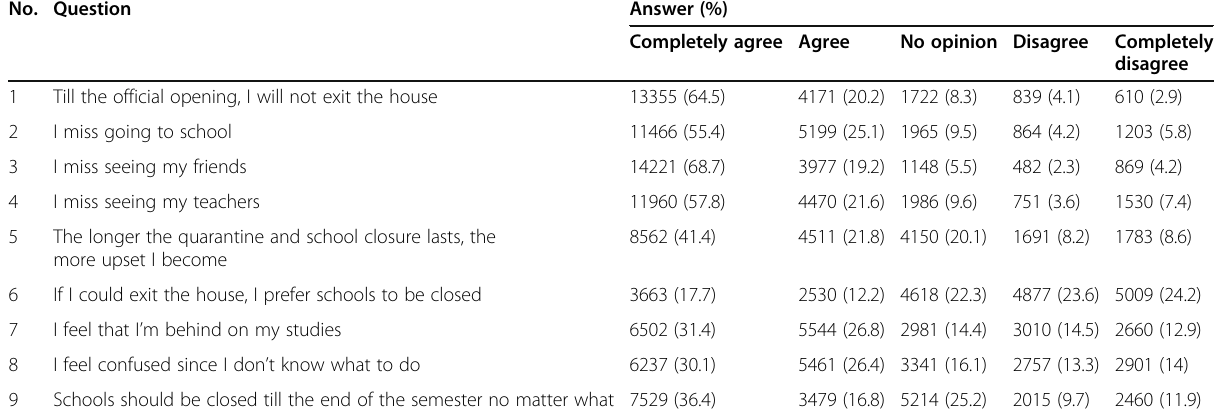
Table 3 Frequency of answers regarding the students ’ attitudes toward school closure No.